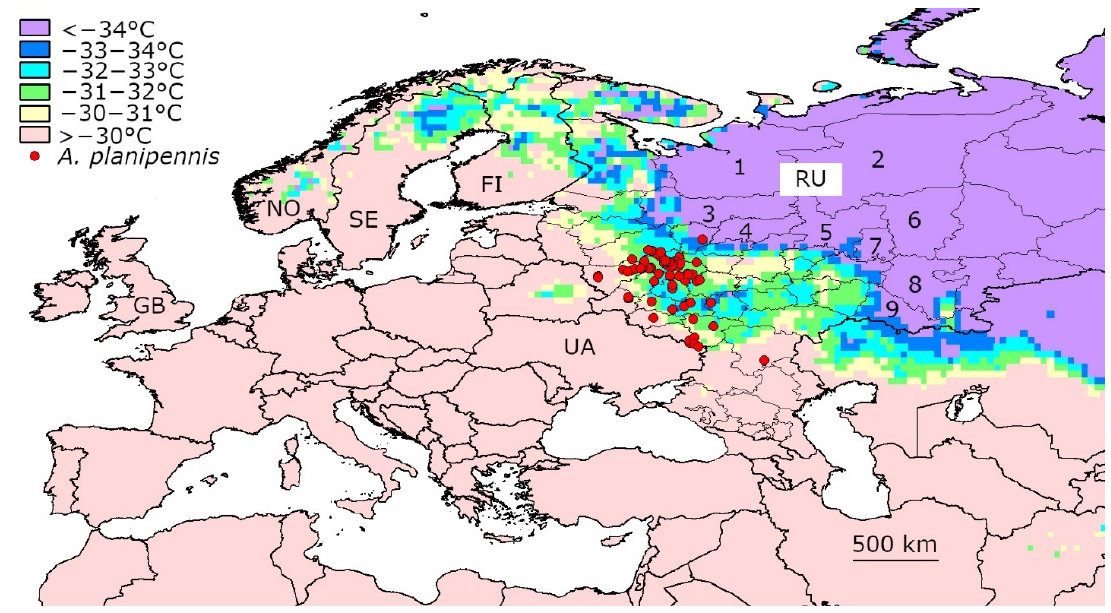
Figure 4. Minimum mean daily temperatures recorded from 2003 to 2019 in northern Europe. FI—